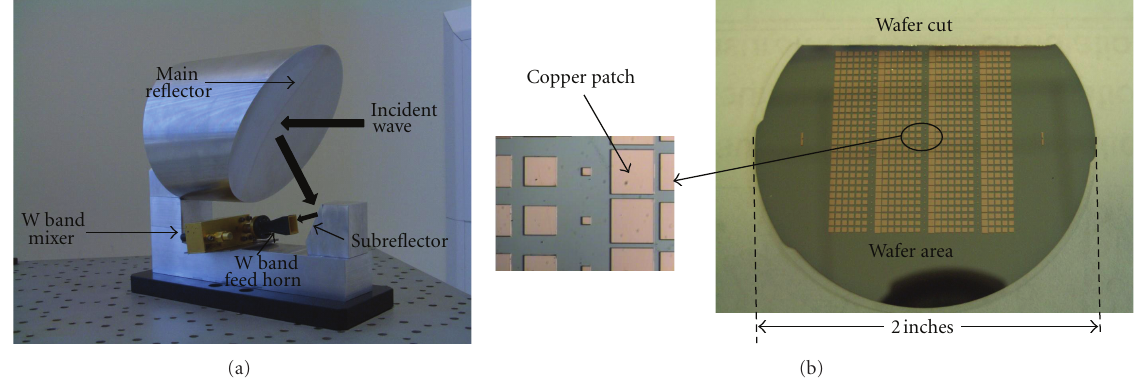
Figure 3: Dual reflector antenna at 94GHz. (a) Photograph and (b) reflectarray subreflector. (From [21] © 2009 IEEE).